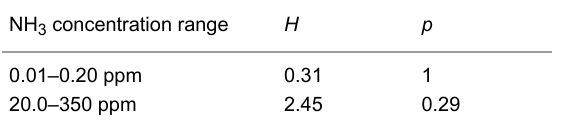
Table 3: Values of H and p determined according to the proposed pro- cessing of the experimental data. NH 3 concentration